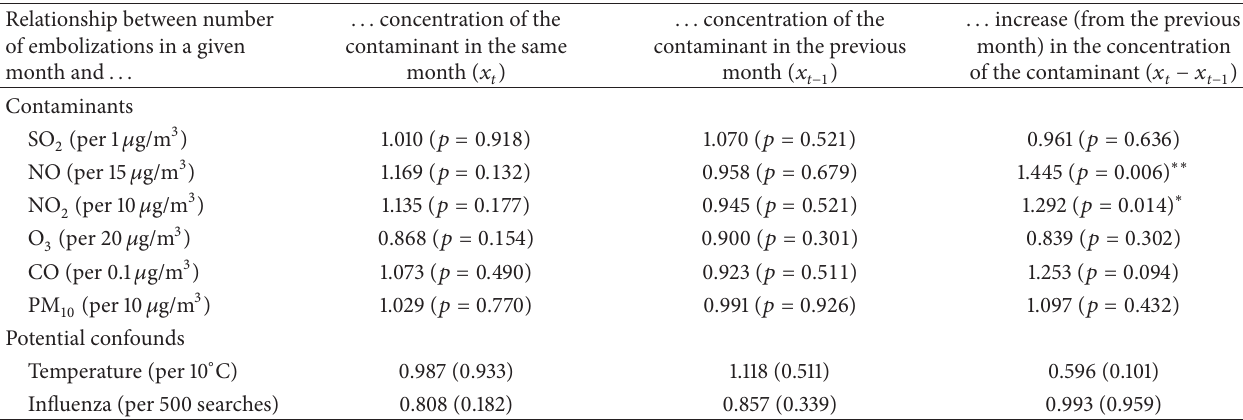
Table 2: Poisson regression exponentiated coefficients of the relationship between concentration of air contaminants and monthly number of